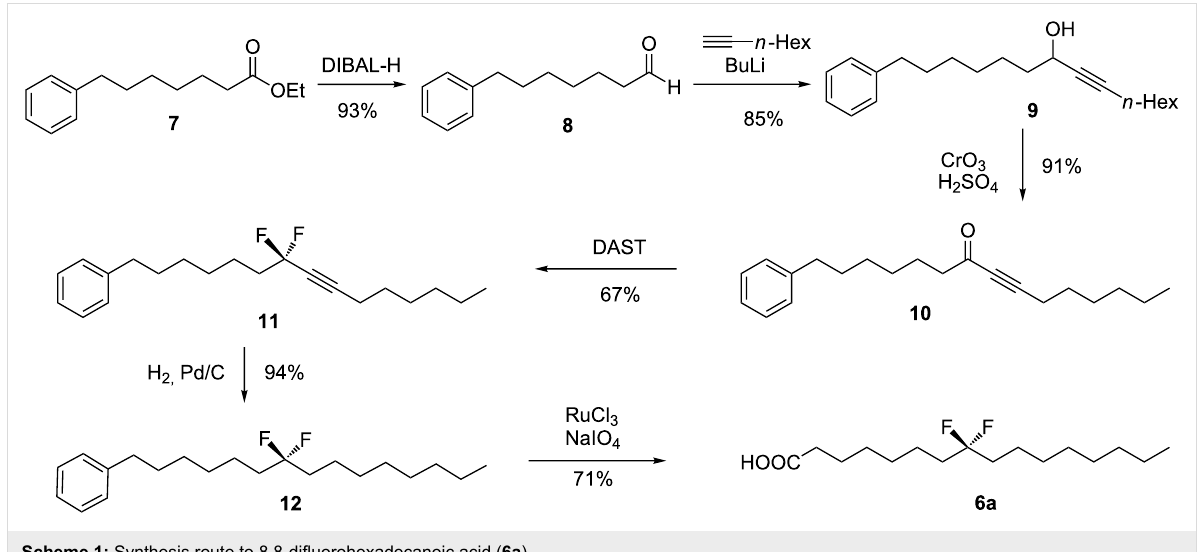
Palmitic acid 6a containing a single CF 2 group at C-8 was prepared as a control compound. The location for CF 2